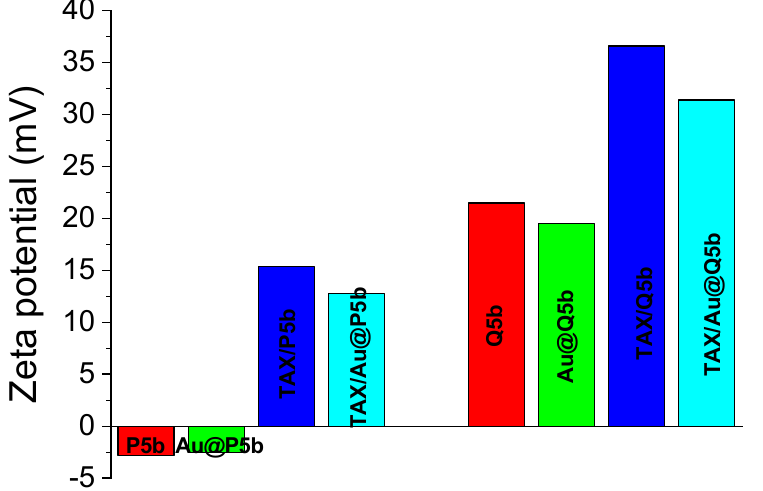
Figure 5. Zeta potential values of pentablock terpolymer bare and hybrid nanoparticles before and after encapsulation of TAX.